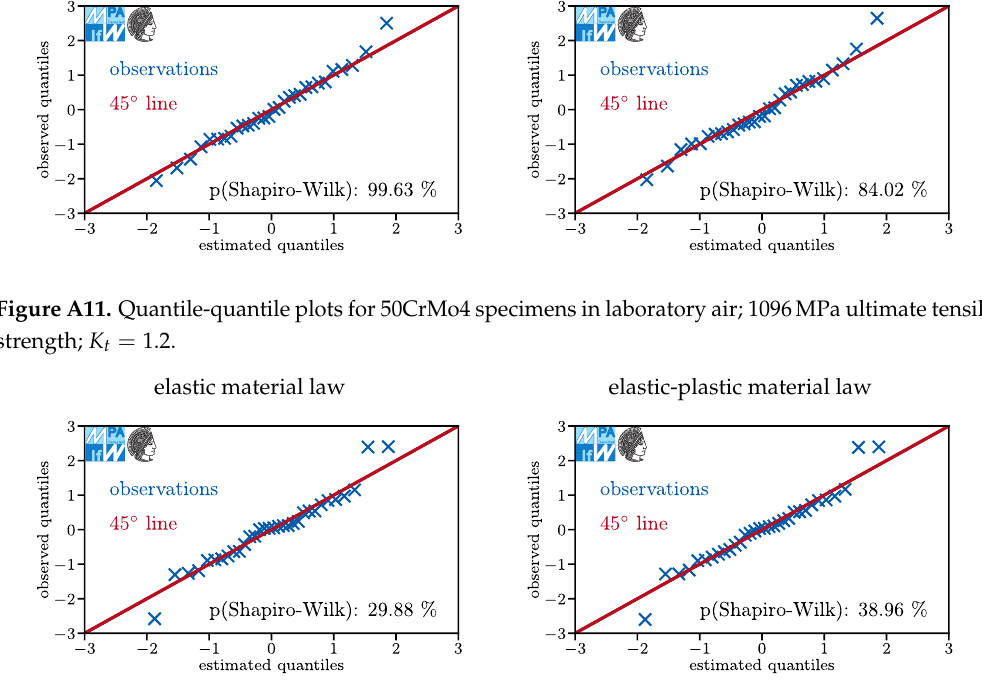
Figure A12. Quantile-quantile plots for 50CrMo4 specimens in laboratory air; 1726MPa ultimate tensile strength; K t =